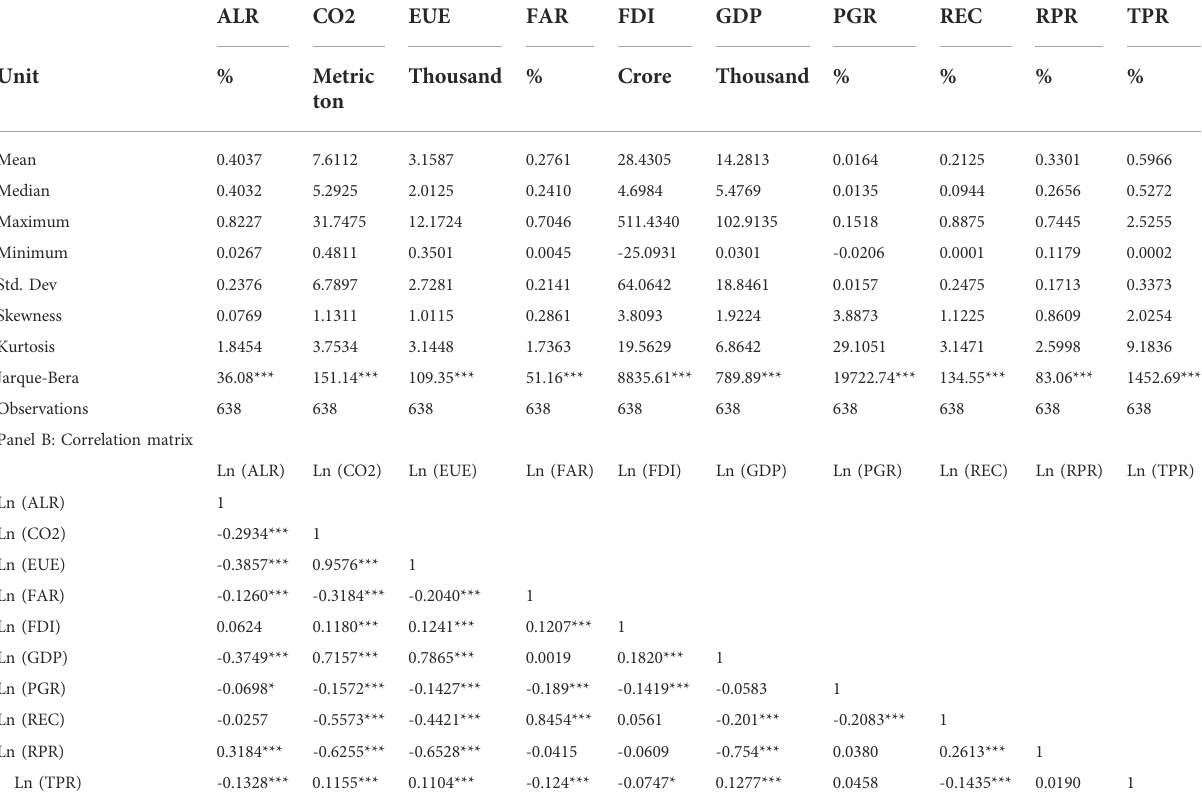
TABLE 2 Summary overviews and correlation. Panel A: Summary statistics